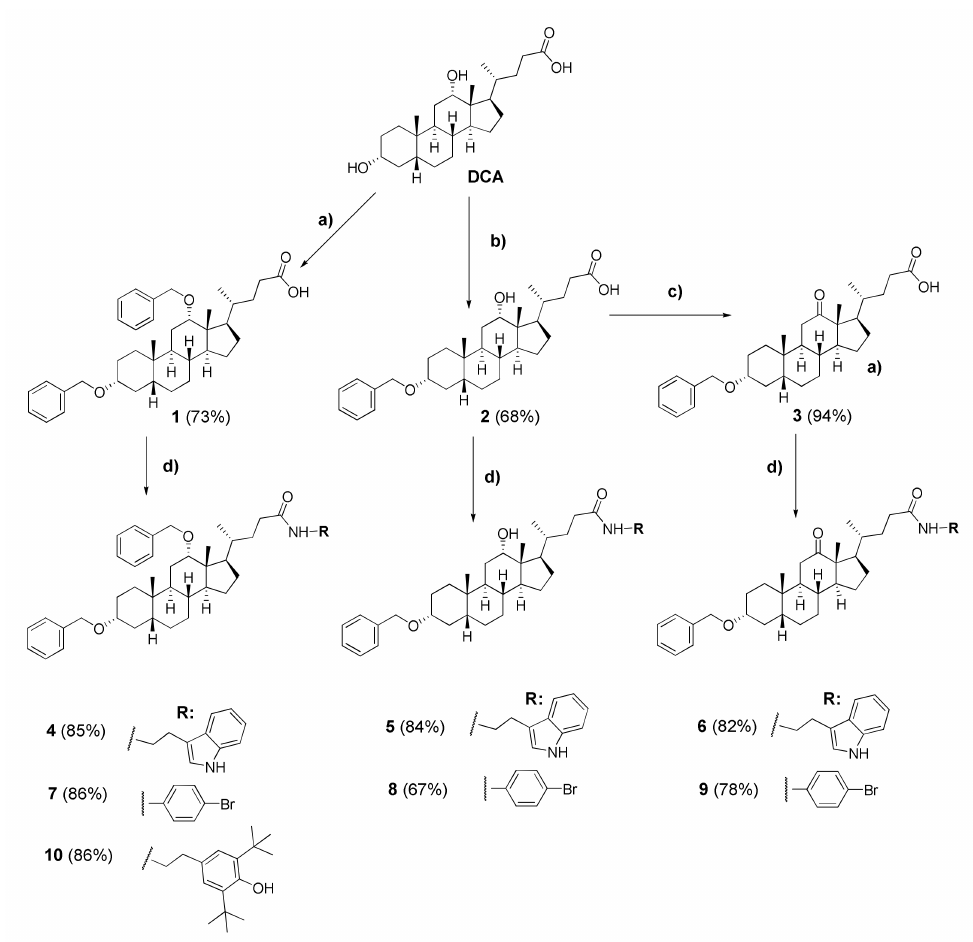
Scheme 1. Synthesis of deoxycholic acid amides with the benzyloxy-group at C-3 and benzyloxy, hydroxy, and oxo-groups at C-12 on the steroid framework ( 4 – 10 ). Reagent and conditions: ( a ) benzyl bromide (4.5 eq.), NaH (~60% in oil), THF (reflux); ( b ) benzyl bromide (3.0 eq.), NaH (~60% in